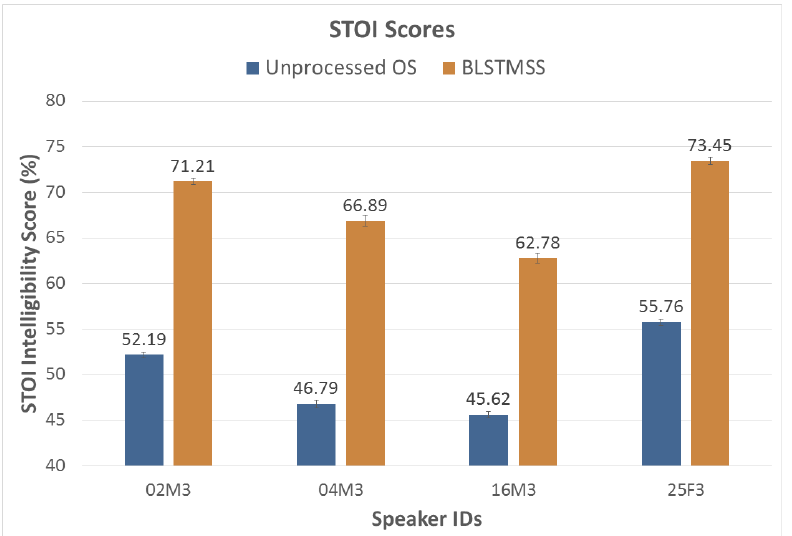
Figure 6. STOI scores for the four OS speakers and the enriched versions. Reference signal for STOI is duration–matched SS. Error bars show standard